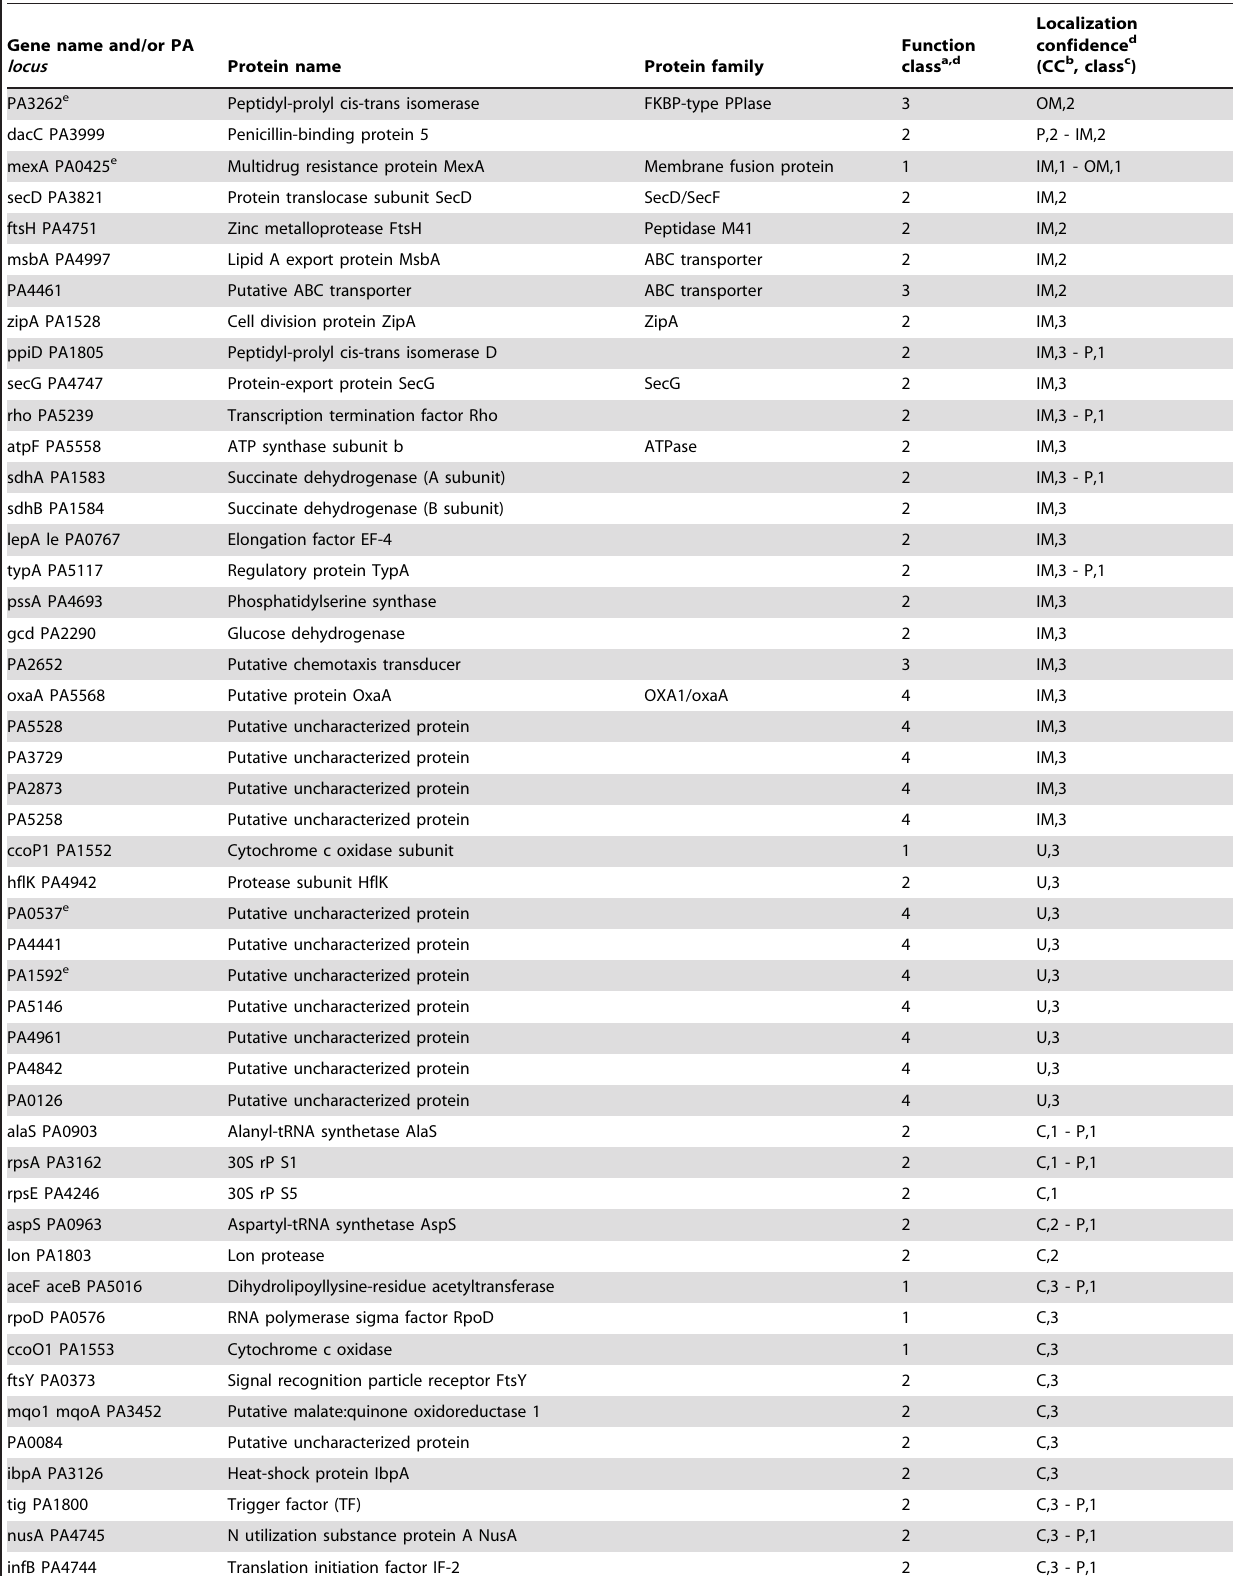
Table 2. List of envelope-associated proteins not directly bound by NPs.